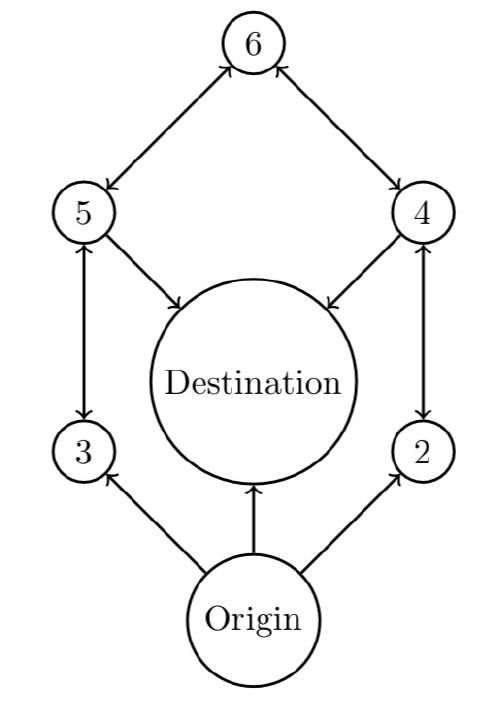
Figure 5. The graph corresponding to the problem of attaining the parasite-free